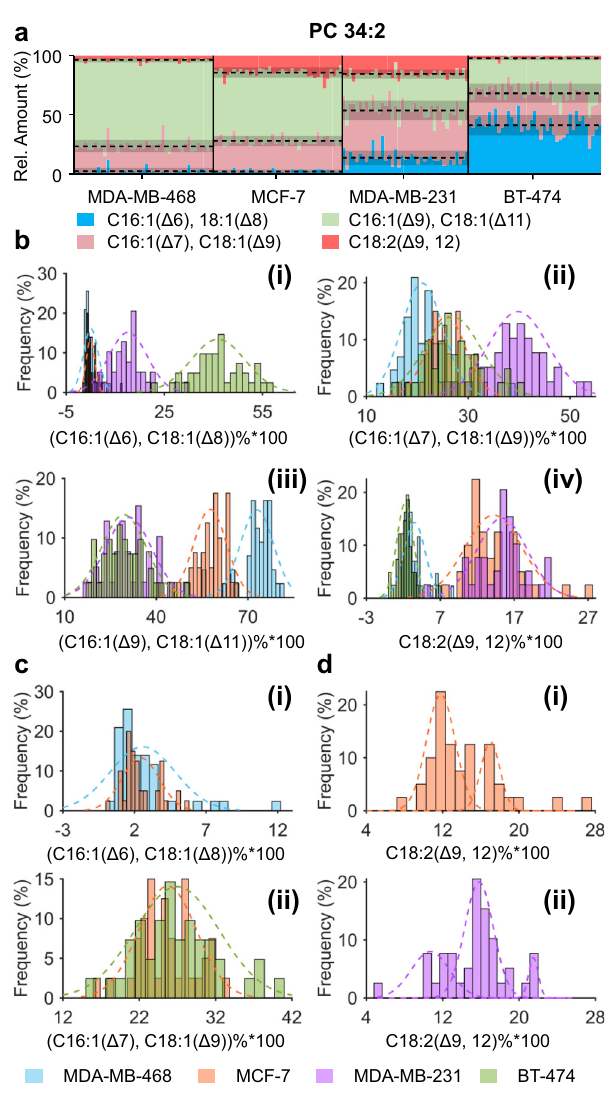
Fig. 4 Relative abundance of structurally de fi ned molecular lipids with C = C location speci fi city in four different subtypes of human breast cancer cell lines. a – d Overview ( a ) and frequency histogram ( b ) of relative abundance of C = C location isomers of PC 34:2 in four types of single cells. c Comparisons of the relative abundance of PC 34:2 with C16:1( Δ 6) or C18:1( Δ 8) between MDA-MB-468 and MCF-7 single cells (i) and PC 34:2 with C16:1( Δ 7) or C18:1( Δ 9) between BT-474 and MCF-7 single cells (ii). d Multi-peaks fi tting of the relative abundance of PC 16:0_18:2( Δ 9, 12) in single MCF-7 cells (i) and MDA-231 cells (ii). The numbers ( n ) of single cells analyzed are 43 for MDA-MB-468, 40 for MCF-7, 39 for MDA-MB- 231, and 41 for BT-474. Source data are provided in a Source Data fi two cell subsets containing 25 or 30 cells (Supplementary Fig. 17b, c) from each breast cancer cell line. The cell classi fi cation is also successful, indicating that such a sample size can be used to represent the whole population. Interestingly, the triple-negative breast cancer cell lines of MDA-MB-231 and MDA-MB-468 have completely different lipid composition in terms of C = C location and fatty acyl isomers, possibly due to genomic differences 58 . with C16:1( Δ 6) or C18:1( Δ 8) in MDA-MB-468 and MCF-7 cells